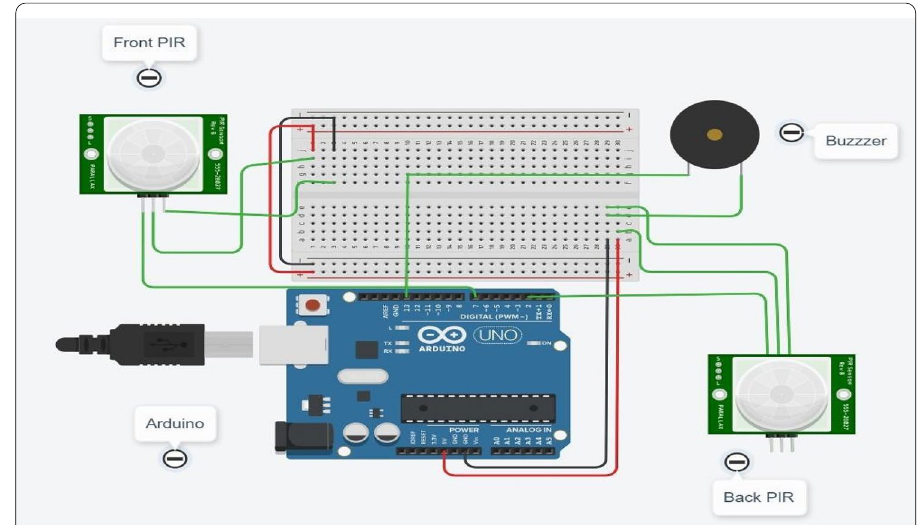
Fig. 6 Arduino Uno with front and back PIR sensor with buzzer